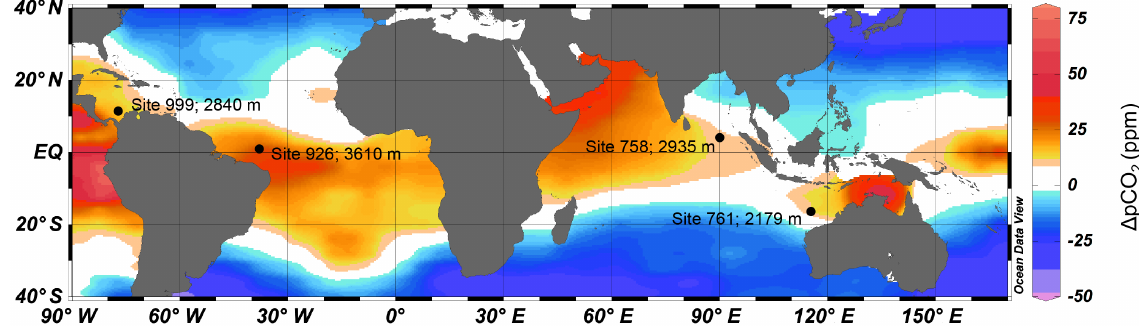
Figure 4. Map of study sites and mean annual air–sea disequilibrium with respect to p CO 2 . The black dots indicate the location of the sites used in this study. ODP sites 758, 999, 926 and 761 used in this study are highlighted with water depth. Data are from Takahashi et al., 2009, plotted using Ocean Data View (Schlitzer,